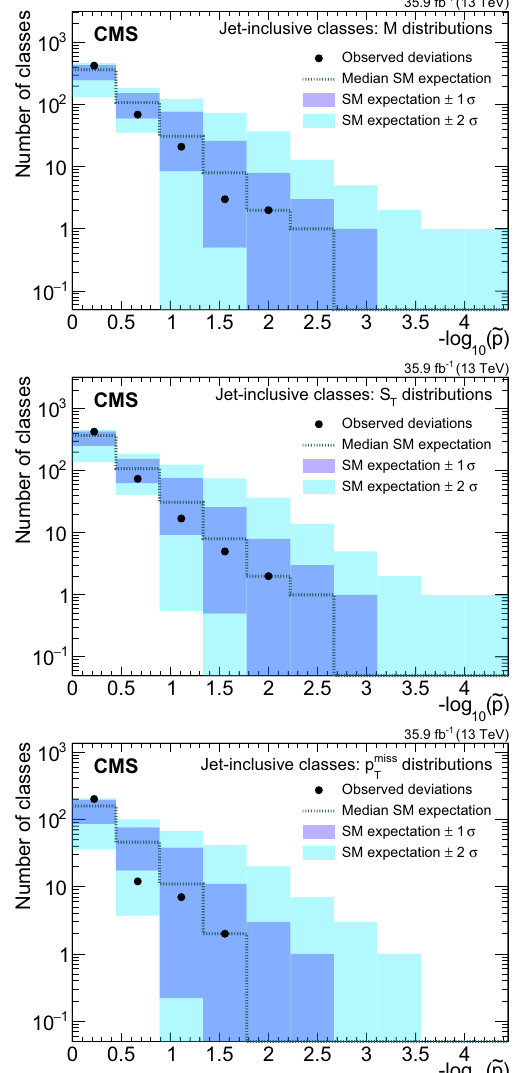
Fig. 13 Distribution of ˜ p values for the RoI scan in jet-inclusive classes for the M (upper), S T (middle), and p miss